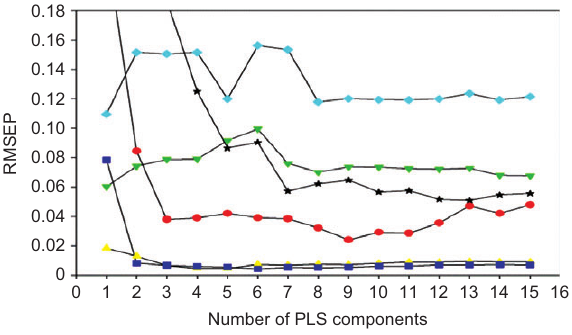
Figure 2 Predictive performance of PLS models built on spectra of the calibration powder samples preprocessed by different methods (red circle, the raw spectra; black star, MSC; cyan diamond, SNV; blue square, OPLEC; yellow triangle up, EMSC; green triangle